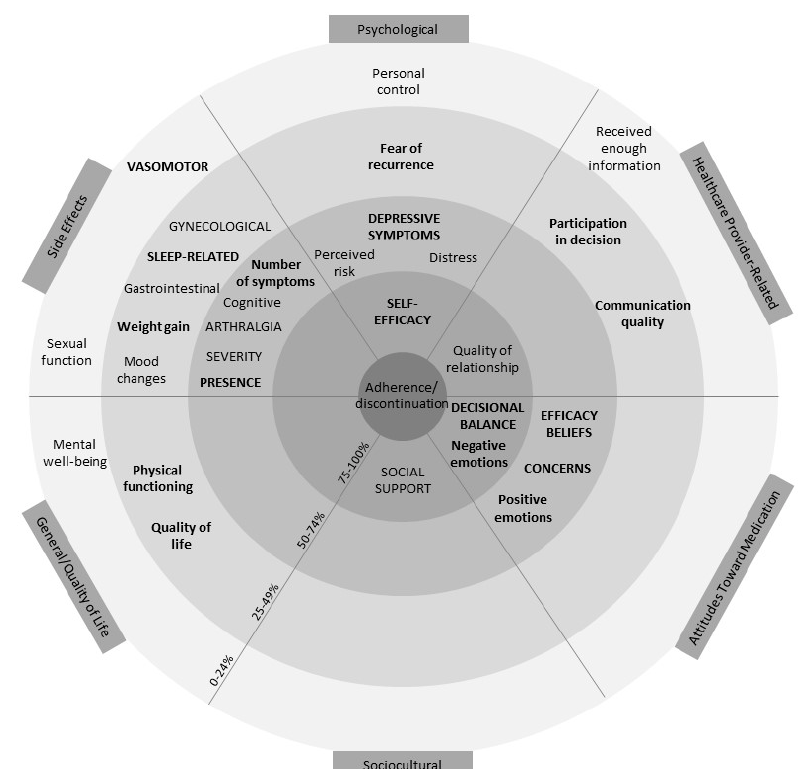
Figure 2. Visual representation of results. Within each of the six categories of factors identified, factors in closer proximity to the centre are associated with adherence a higher proportion of the time (0–24% in the outermost and 75–100% in the innermost ring). Factors in lowercase lettering have been examined ≥ 5 times, and factors in uppercase lettering have been examined ≥ 10 times. Bolding represents factors associated at least as often in multivariate models as in univariate models. Thus, factors in uppercase lettering, closest to the middle, and bold (i.e., self-efficacy and decisional balance) represent the most robust associations. Factors that were examined <5 times were not included in this